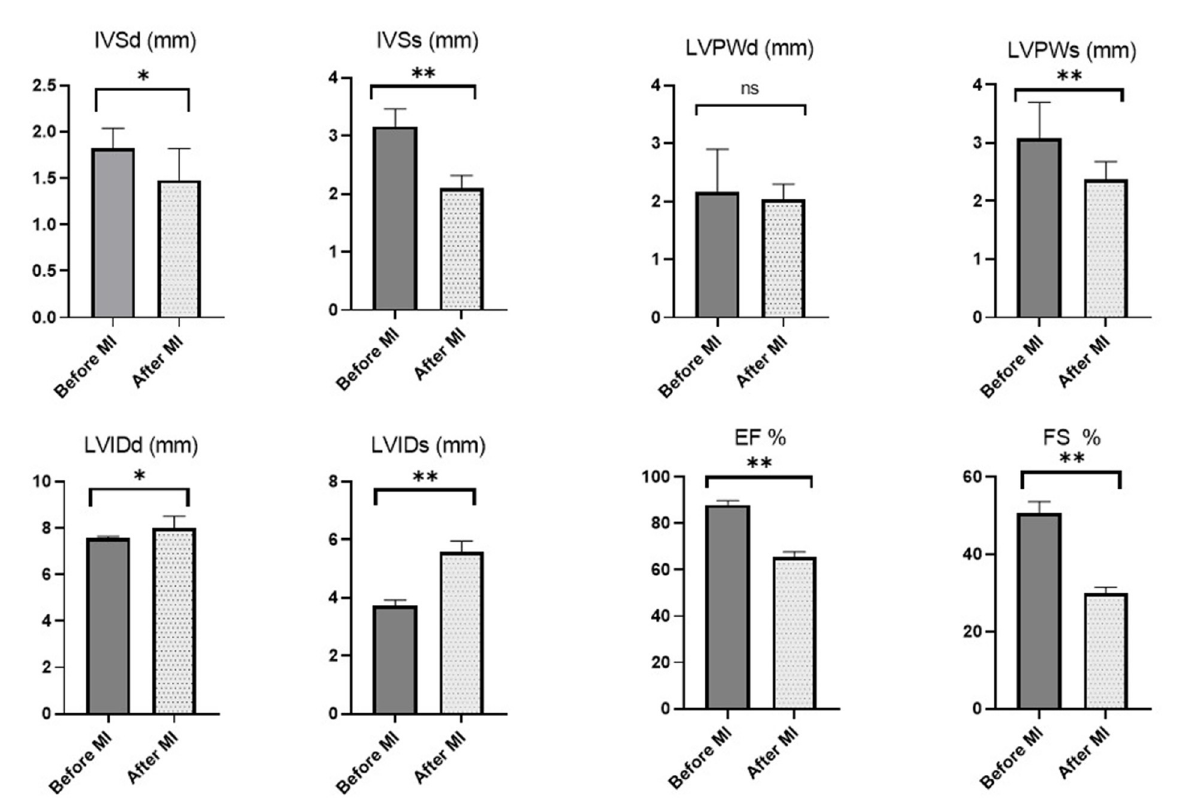
FIGURE5 Echocardiographic measurements in rats before MI induction and 1 month later. Asterisk used to indicate the significance, Ns P > 0.05 , * p < 0.05, ** p < 0.01.